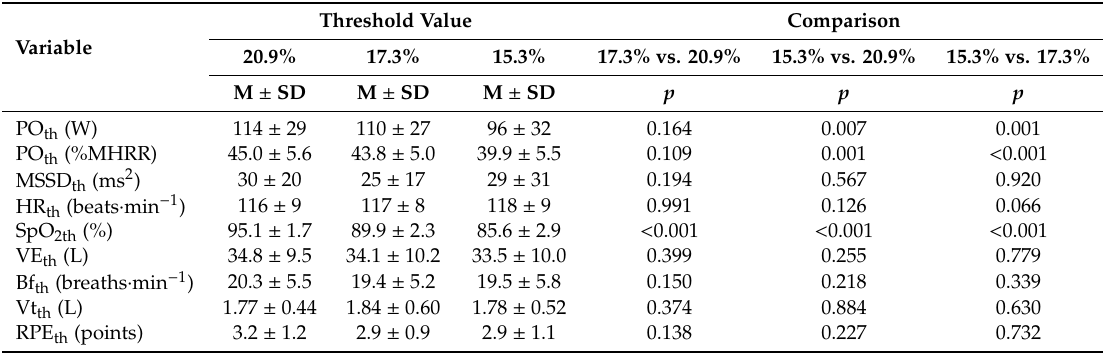
Table 2. Threshold values of physiological and psychometric variables at normoxia (FiO 2 = 20.9%)